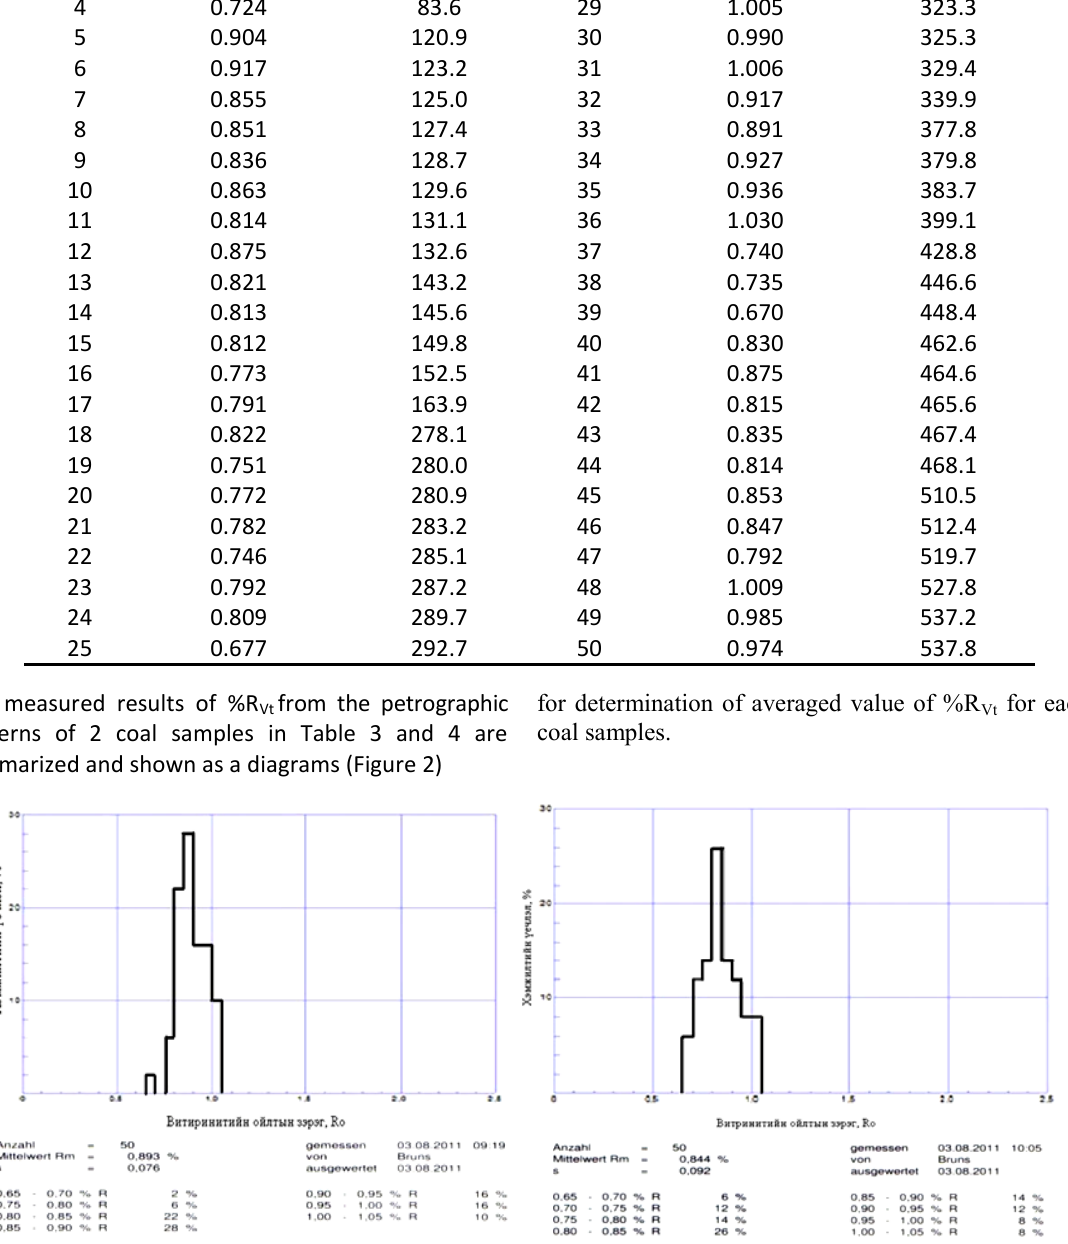
A – for borehole IV; B - for borehole